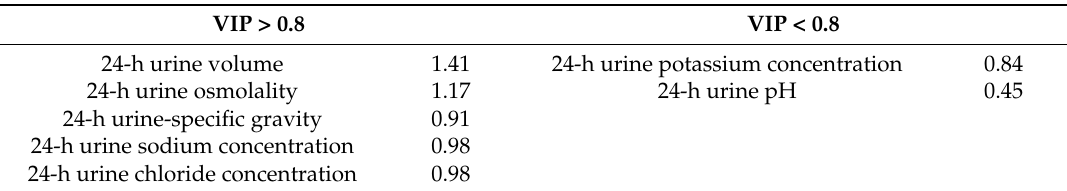
Table 6. Variable importance in projection (VIP) coefficients for 24-h urine hydration biomarkers in the partial least squares (PLS)